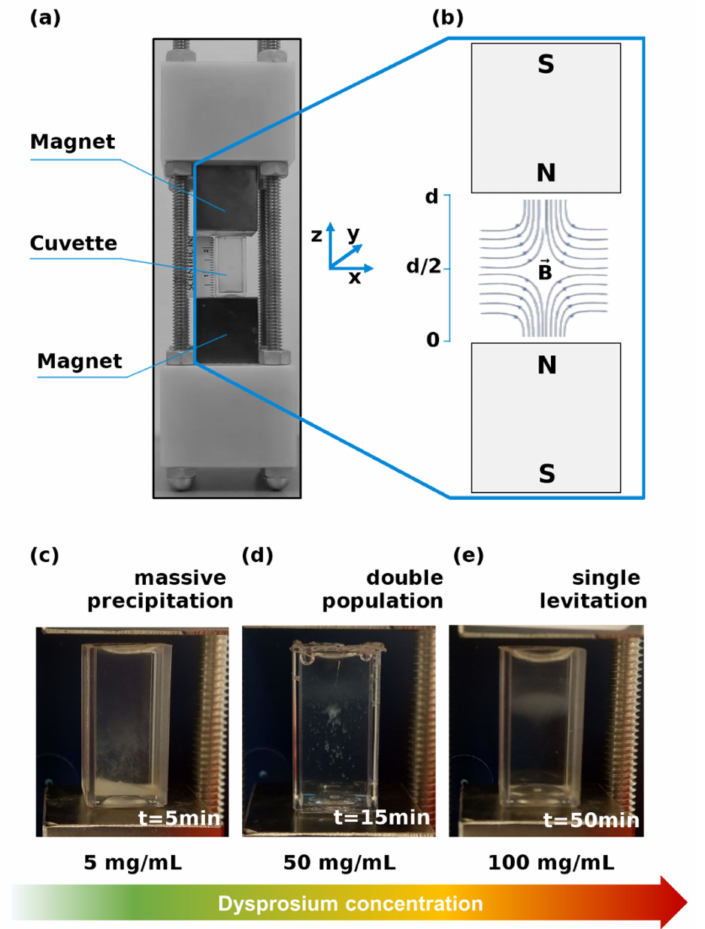
Figure 1. ( a ) Photograph and ( b ) scheme of the MagLev platform. The magnetic levitation patterns of HP in dysprosium nitrate depended on the concentration of the paramagnetic solution. ( c ) At low concentrations, HP precipitated in 5 min. ( d ) At intermediate concentrations, a stable levitating population coexisted with a precipitating one, which reached the bottom in about 15 min. ( e ) At high concentrations, HP levitated in a larger time scale (up to about 50